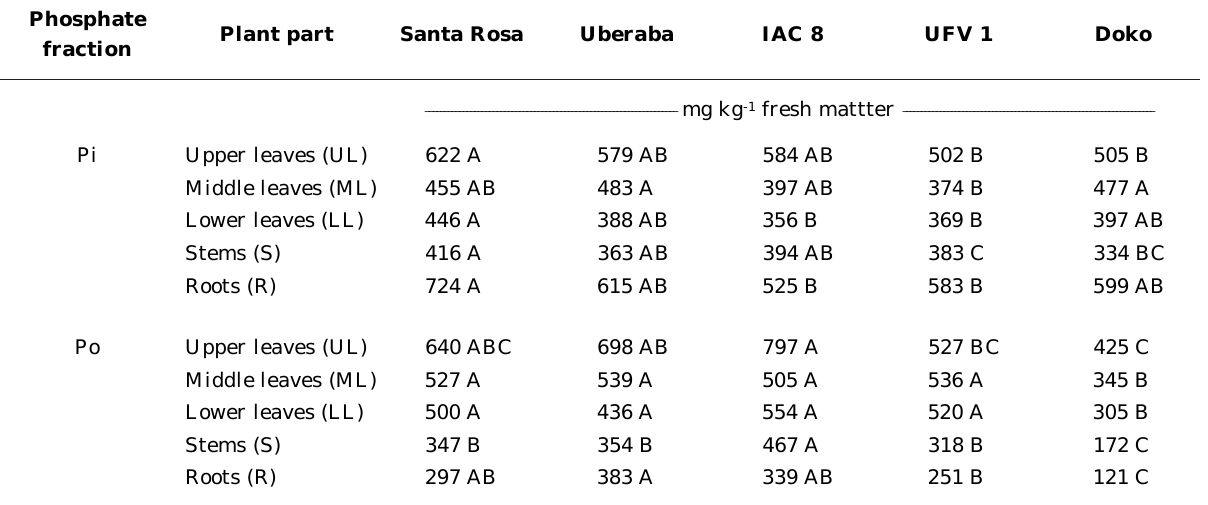
Table 1. Inorganic P (Pi) and organic P (Po) concentration in upper, middle and lower leaves, stems, and roots of soybean cultivars grown in complete nutrient solution for 31 days Phosphate Plant part Santa fraction